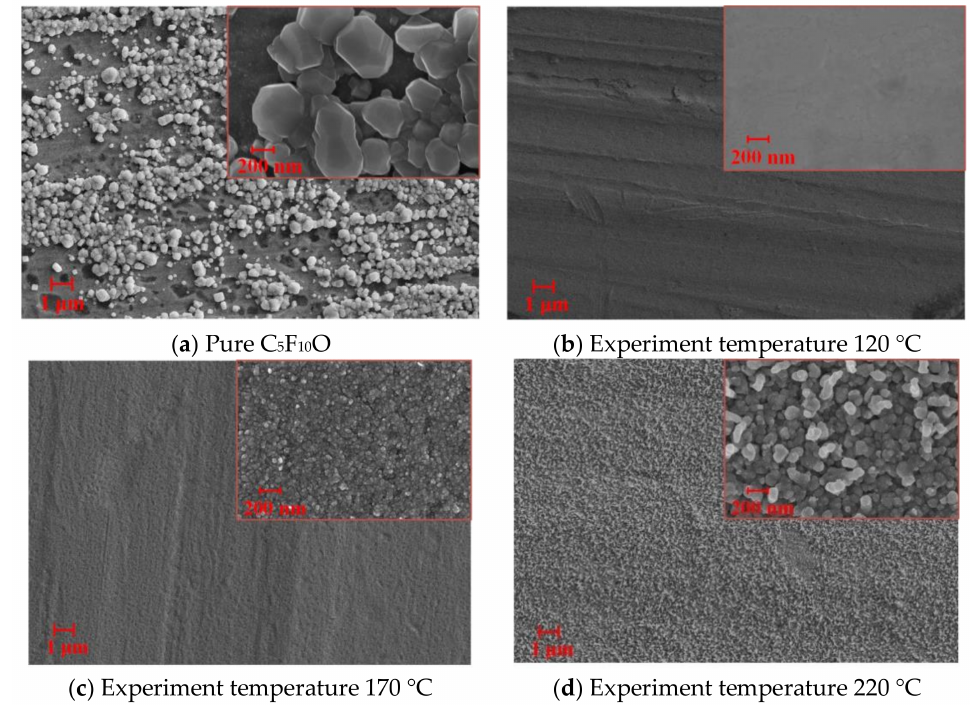
Figure 6. FESEM morphology of the surface after contact of copper with C 5 F 10 O/air gas mixtures. Figure 6 shows the surface morphology of the copper in the C 5 F 10 O/air gas mixture experiment group and the pure C 5 F 10 O experiment group. When viewed under an electron microscope, the surface of the copper sample of the pure C 5 F 10 O experimental group